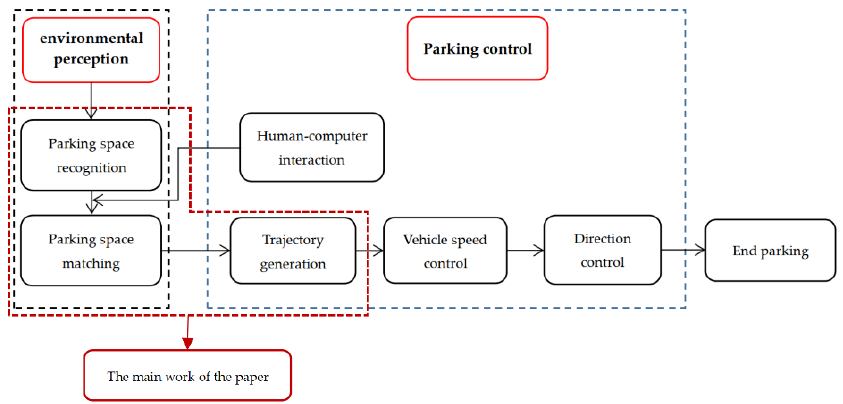
Figure 8. The workflow of the automatic parking system.